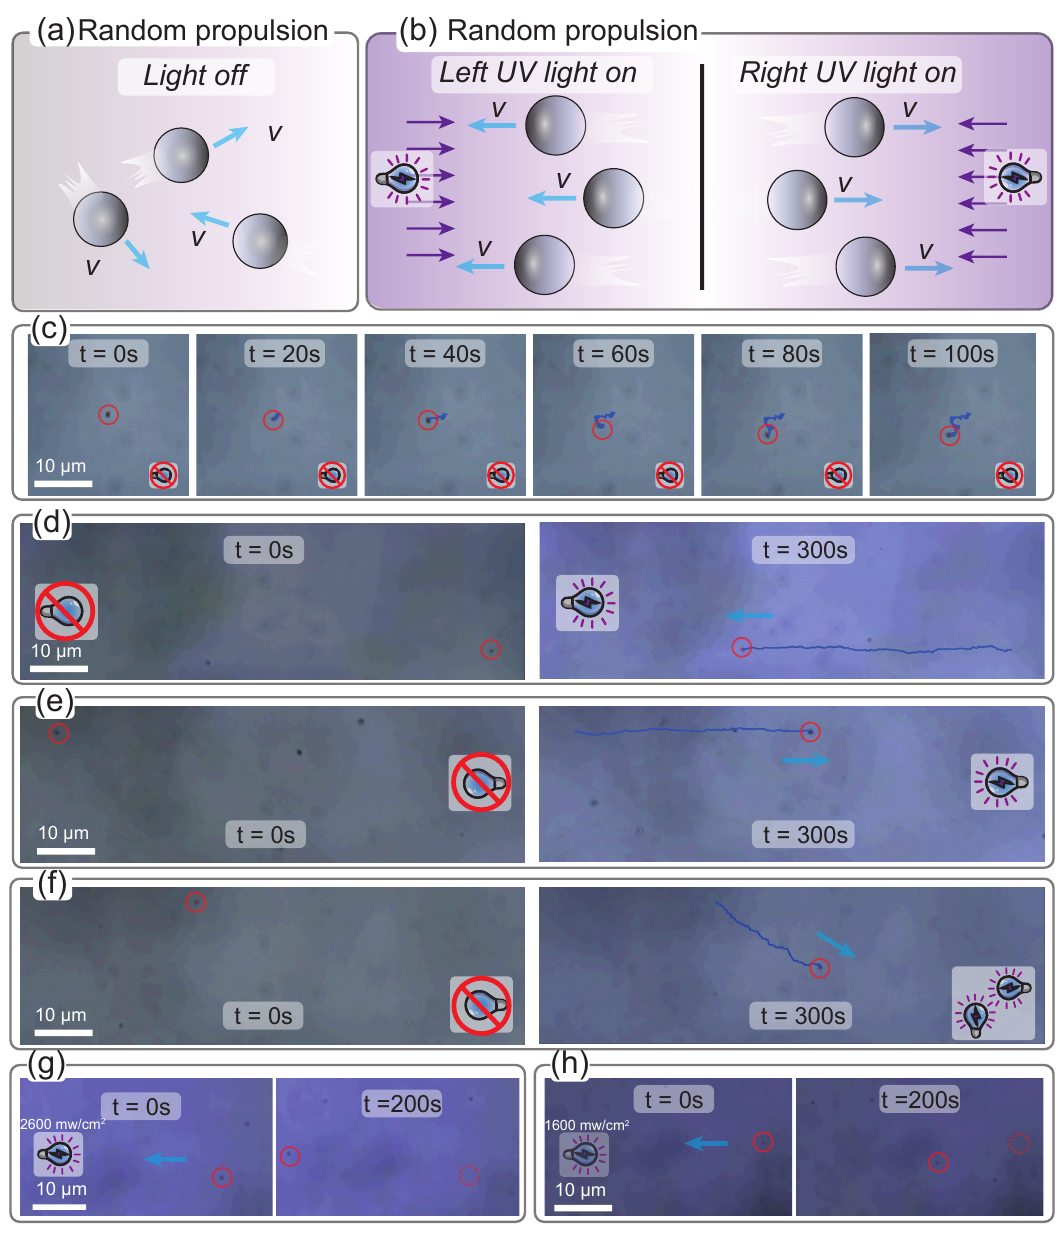
Figure 3. The motion behavior test experiment of a single TiO 2 microrobot under the action of multiple light fields. Schematic diagram of the motion behavior of TiO 2 microrobots with no UV light field ( a ), and UV light field from left and right ( b ), respectively. ( c ) Random propulsion experiments of the TiO 2 robot in the absence of light. The inside of the red circle is the location of the robot. Light-driven locomotion behavior of the TiO 2 microrobot under left-side ( d ) and right-side ( e ) UV illumination. Light blue arrows indicate the direction of movement. ( f ) Motion behavior of the TiO 2 microrobots under a compound UV light field with the right and lower light sources turned on. Movement of TiO 2 microrobot under a strong ( g ) or weak ( h ) UV light field with the dashed red circle indicates the initial position of the